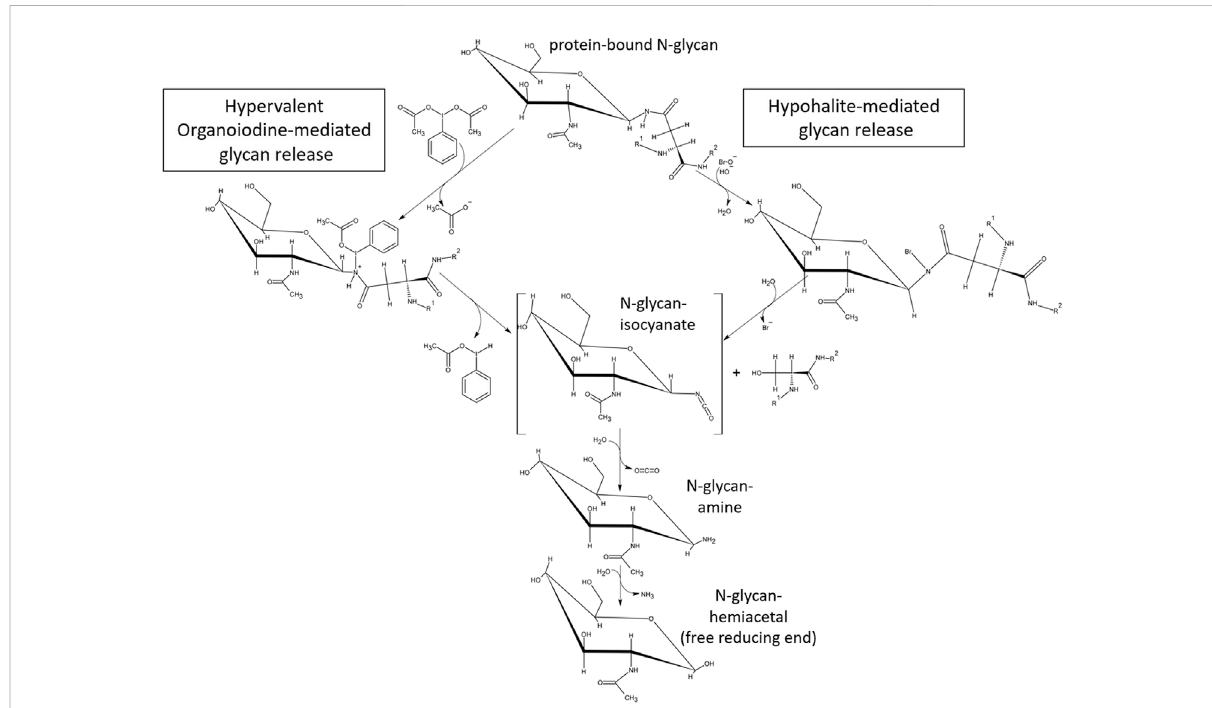
FIGURE 10 Proposed mechanism for glycan release by chemical reactants capable of forming an N-haloamide intermediate with glycoprotein- carboxamides followed by cleavage of the bond between the gamma-carbonyl- and beta-carbon of asparagine. The proposed mechanism for hypohalite mediated glycan release has been proposed previously by Song et al. (2016) and involves alkaline abstraction of a carboxamide N-H-proton, reaction of the resulting N-anion with the halogen atom of hypohalite, formation of the covalent N-haloamide and its rearrangementinto an isocyanate. Hypervalent organoiodine (III) compounds (example shown: diacetoxy-iodobenzene, DIB) carrying a positive net atomic charge on the halogen form an intermediate N-iodoamide in the absence of alkaline conditions and the subsequent dissociation of